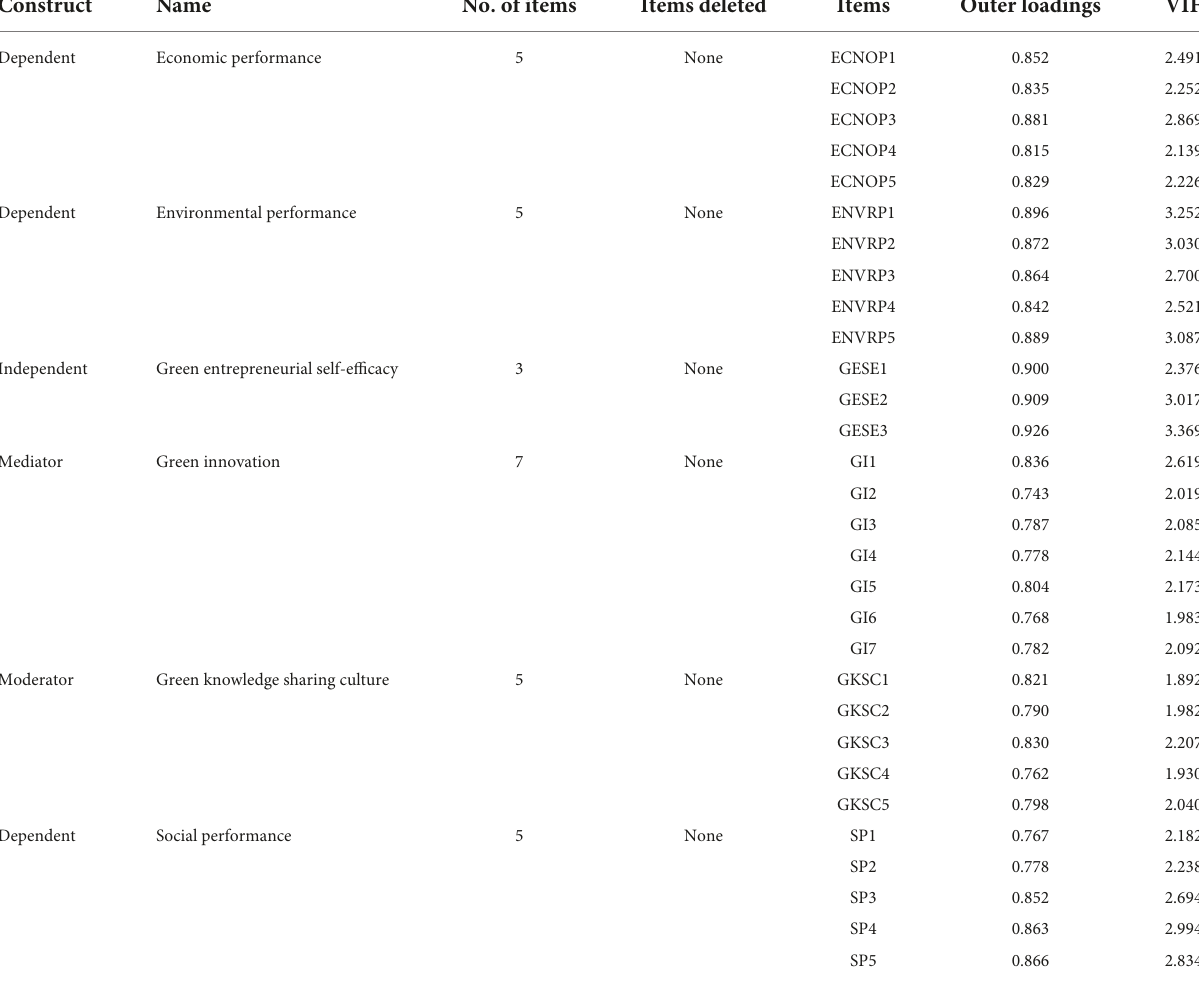
TABLE 2 Outer model